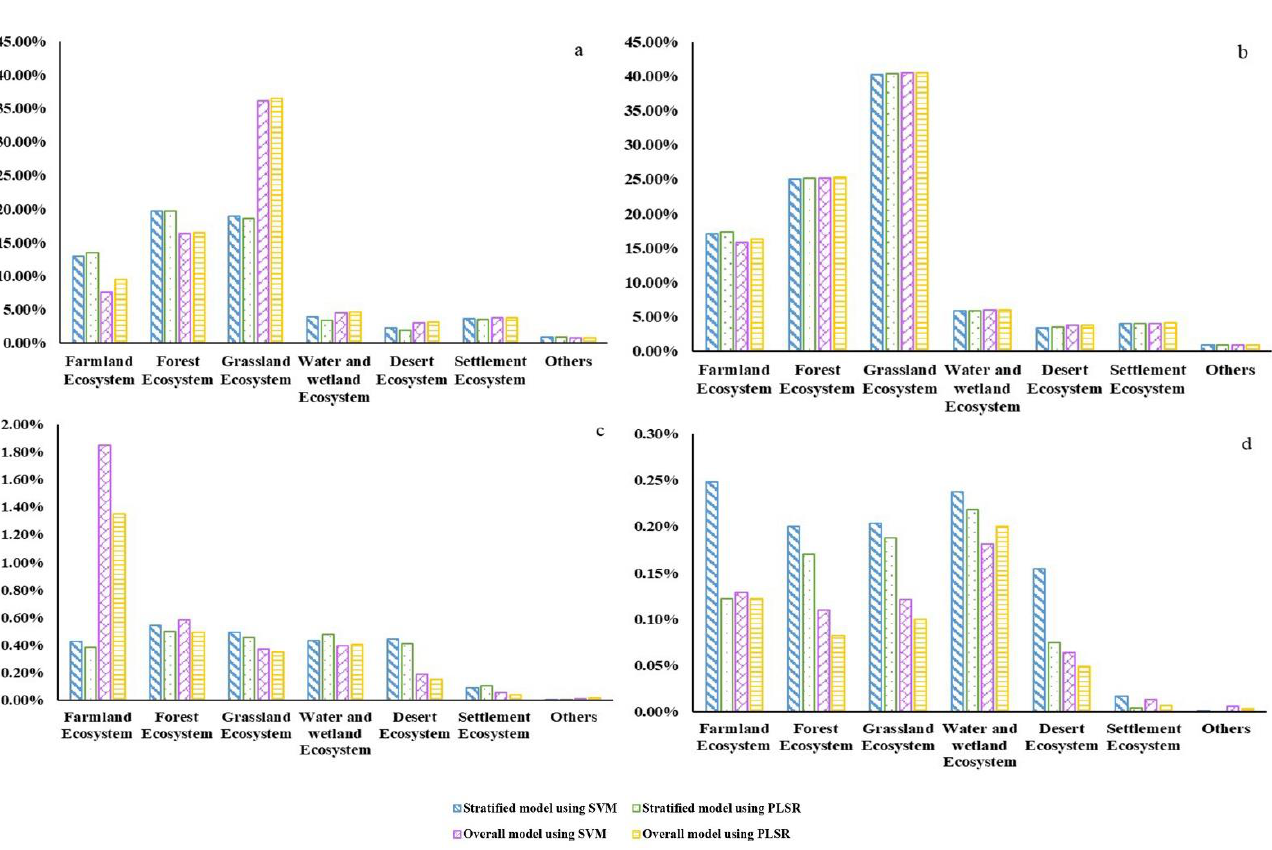
Figure 11. The ratio of the number of standardized residuals of each ecosystem type in the four intervals to the total pixels in the entire study region by the stratified support vector machine (SVM), stratified partial least squares regression (PLSR), overall SVM, and overall PLSR models, respectively: ( a ) using the standardized residuals in the range of − 1 to 1, ( b ) using the standardized residuals in the range of − 2 to 2, ( c ) showing the proportion of doubtful values, and ( d ) showing the proportion of abnormal values.